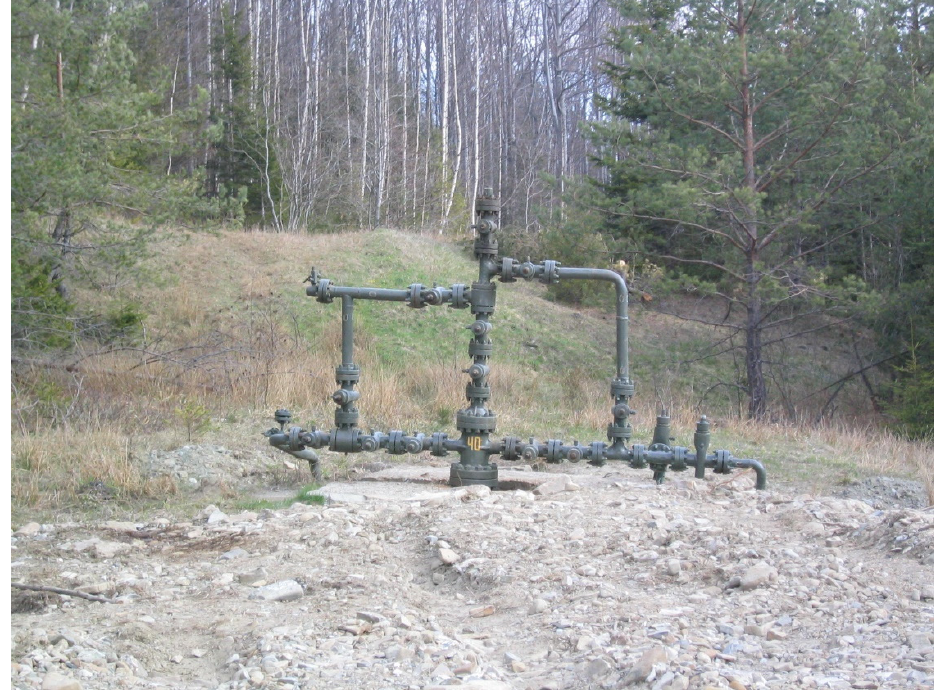
Figure 1. Production tree incline.